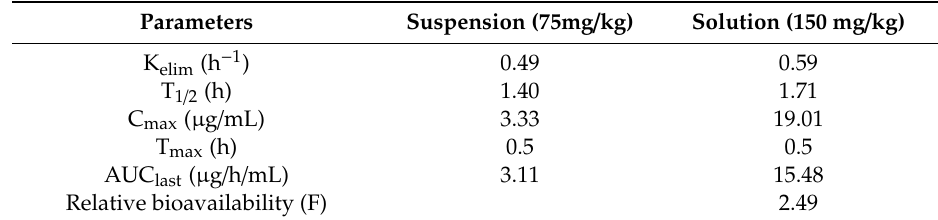
Table 4. Pharmacokinetic parameters of Galunisertib in mice following a single oral dose of two different formulations.